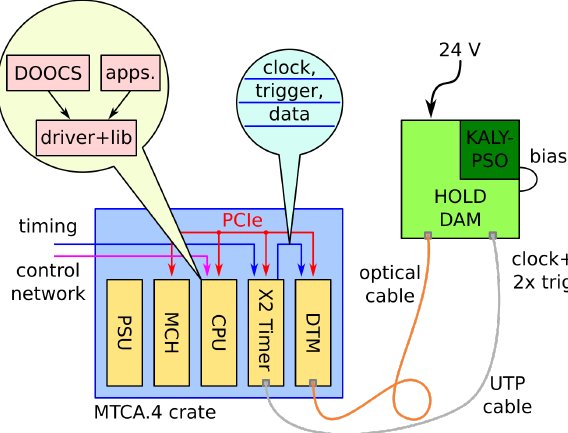
Figure 3. The general structure of the HOLD system.